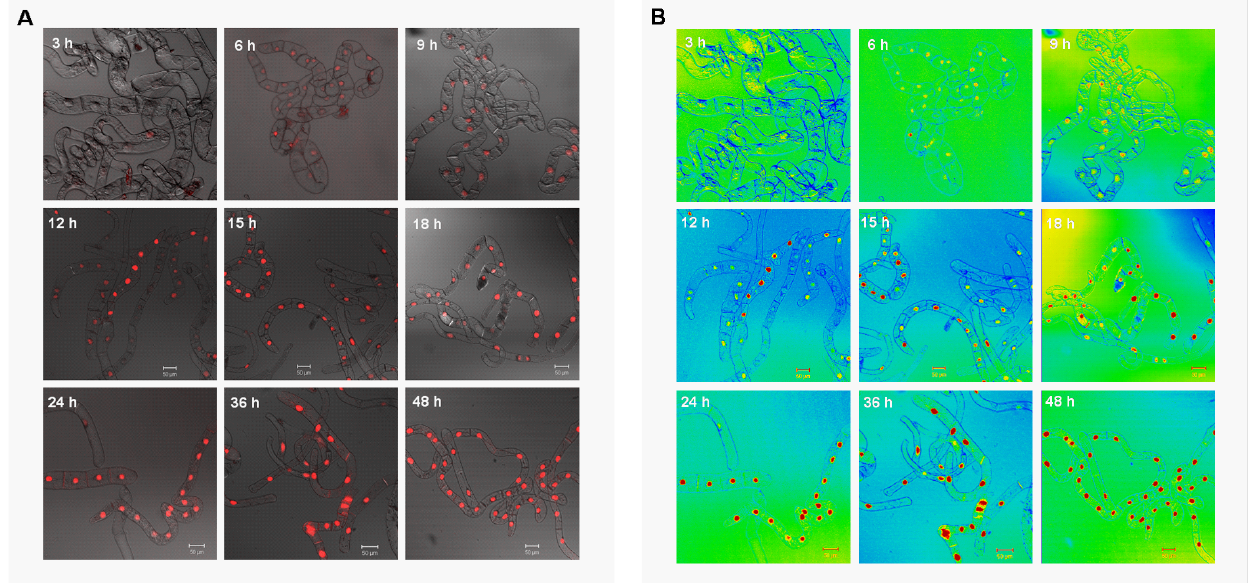
Figure 7. Time course of induction for the NLS-mRFP. In vivo targeting of the NLS-mRFP fusion protein after induction with 6 µM Est (and in the presence of 10 µM Dex – not shown). The red fluorescent signals were examined at different time points after induction. A ) Overlay of transmission microscopy images with the RFP channel. B ) Same images as in A shown in LSM image browser rainbow mode (red indicates saturated areas). Saturation is already reached after 24 h of induction with both elicitors. All images were acquired with the same microscope settings (red channel, Carl Zeiss LSM510 microscope; EC-Plan-Neofluar, 10x/0,3 M27)